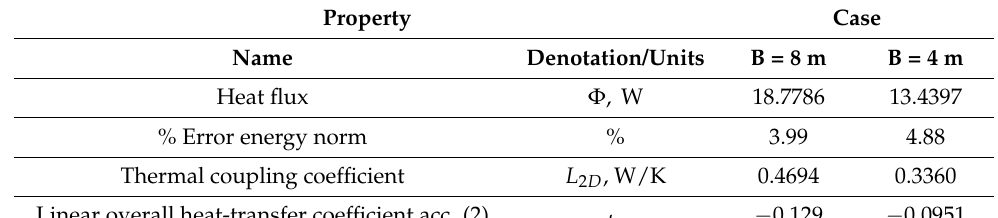
Table 4. Results of linear calculations of the overall heat transfer coefficient.